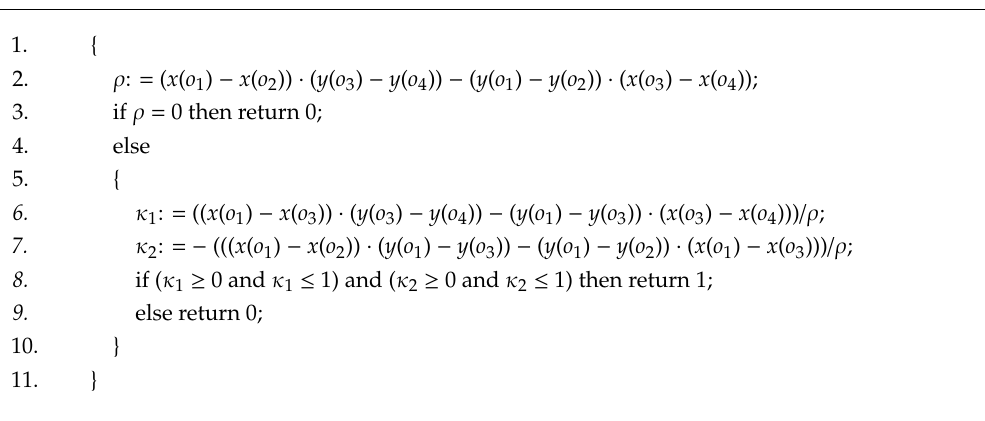
Algorithm 1 EEI ( o 1 , o 2 , o 3 , o 4